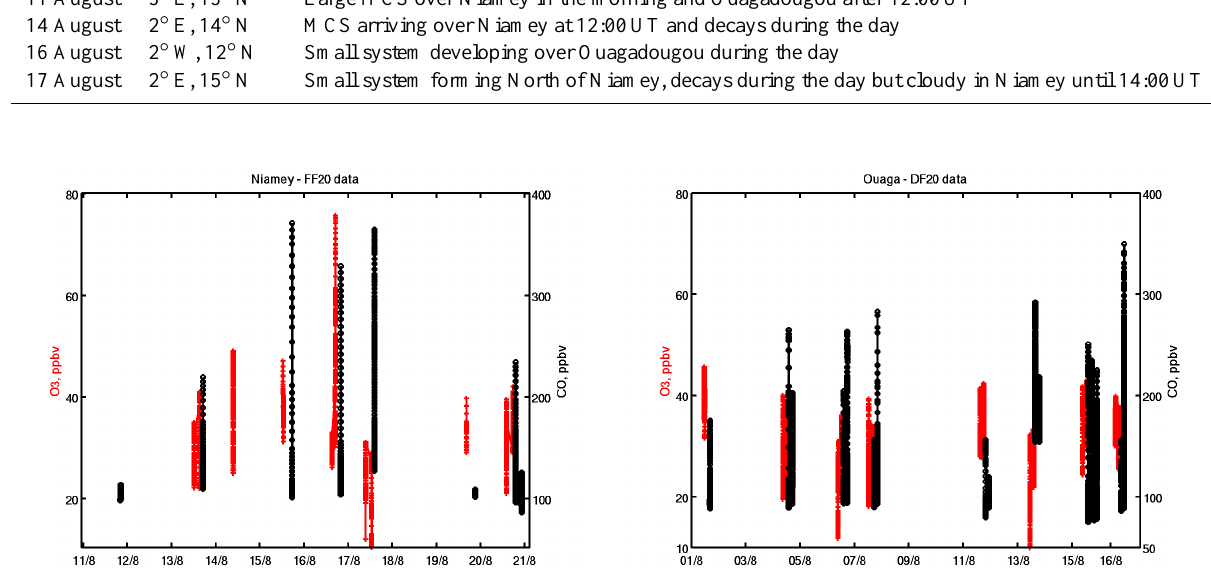
Fig. 4. Daily variability of O 3 (red) and CO (black) mixing ratio range measured in the 0–3km altitude range by the the FF20 near Niamey – left panel, (a) – and the DF20 near Ouagadougou – right panel, (b) . production (Chatfield and Delany, 1990; Reeves et al.,